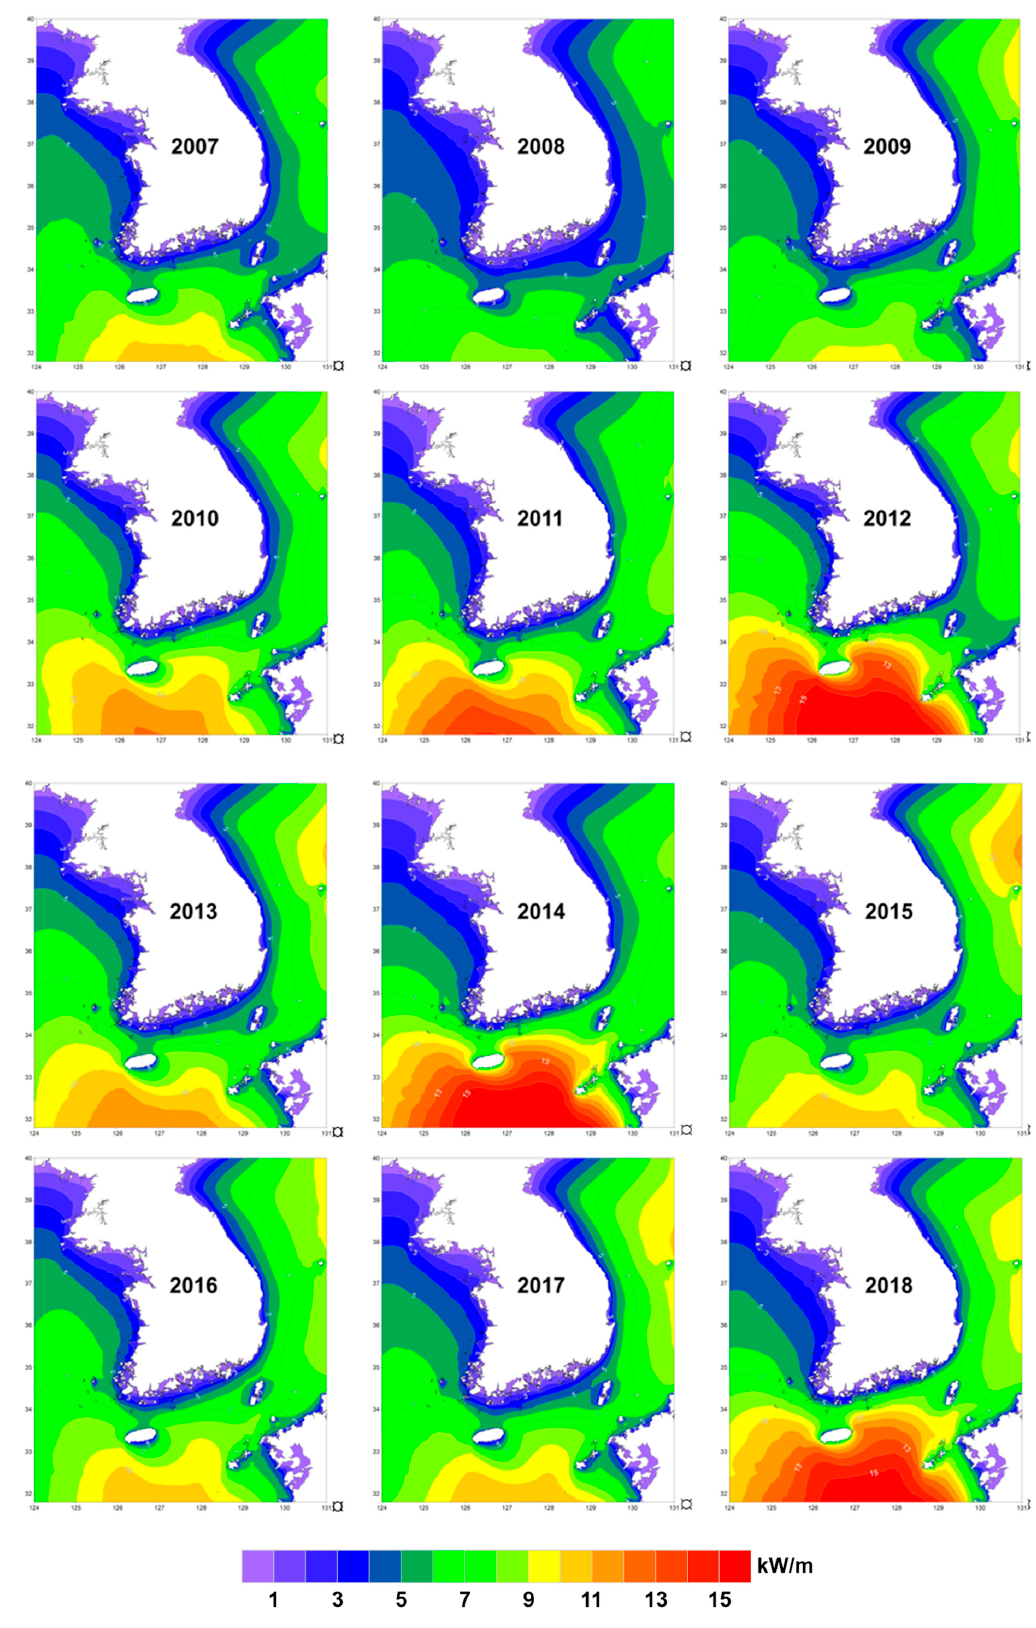
Figure 7. Yearly wave power average around the Korean Peninsula over